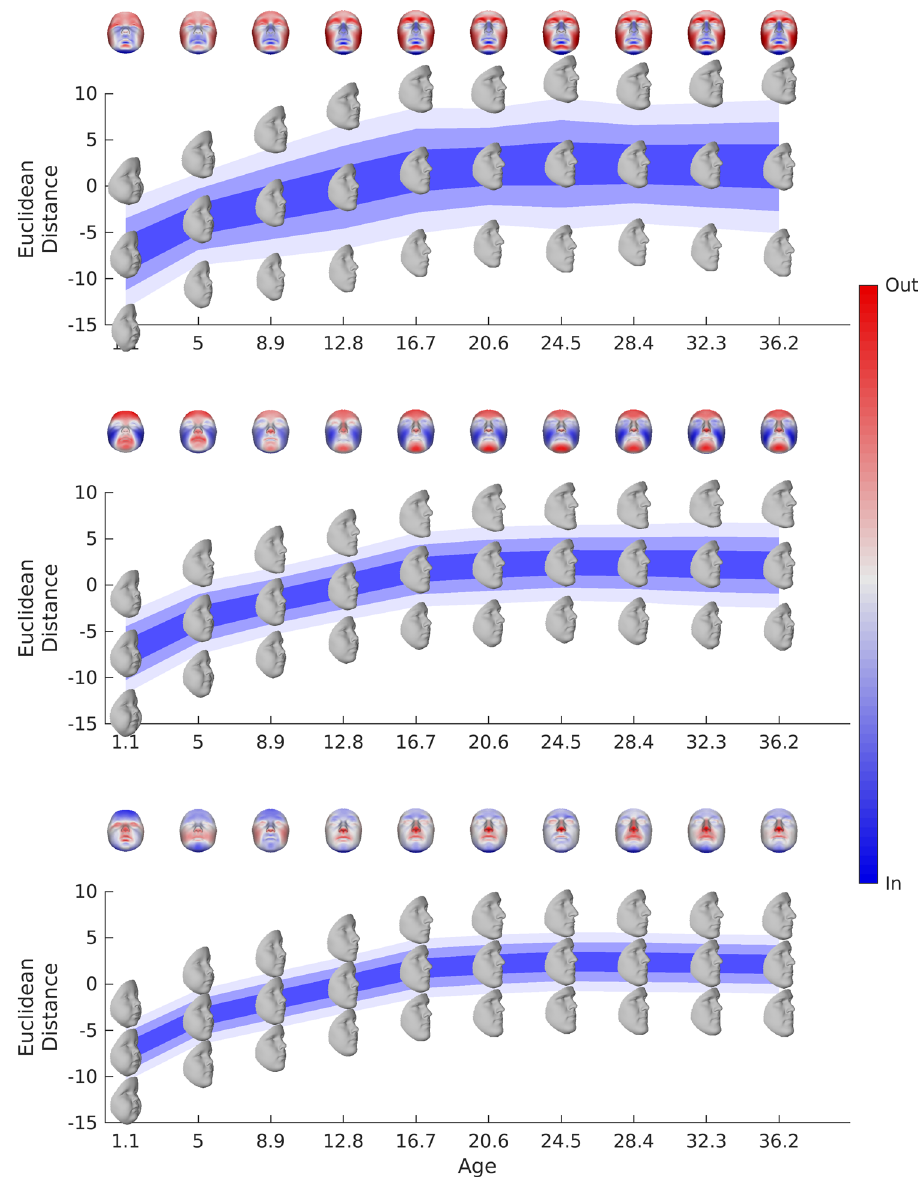
Figure 2. Age-specific statistical shape models for males. This figure shows the first 3 modes of variation (top to bottom) for males at some example ages (horizontal axis). The faces in the center of each panel are the expected faces and their position along the vertical axis is their projection on the first mode of variation of the expected faces. Change in the position of these faces on this axis represents the change in shape of the expected faces along this aspect of variation in Euclidean distance (square root of the sum of squared differences between all pairs of corresponding points). The outermost faces are the expected faces morphed to plus or minus three standard deviations along the mode of variation (mode 1-mode 3; top to bottom). The graded colors represent the span of ± 1(dark) ± 2 (lighter) and 3 (lightest) standard deviations, also in Euclidean distance. This figure was generated in MATLAB 2021a (https:// www. mathw orks.